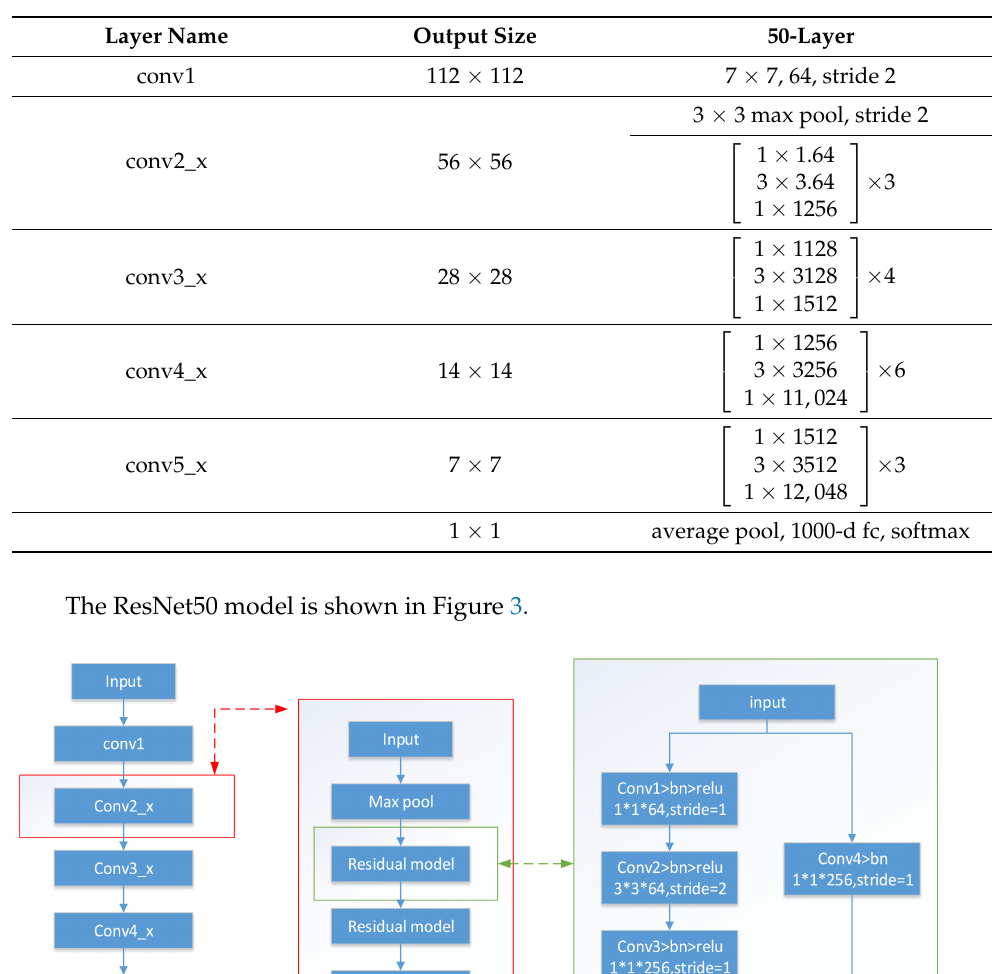
Table 1. ResNet model parameters.